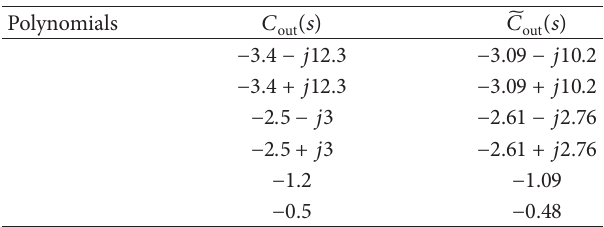
, ̃𝐶 roots comparisons. out out